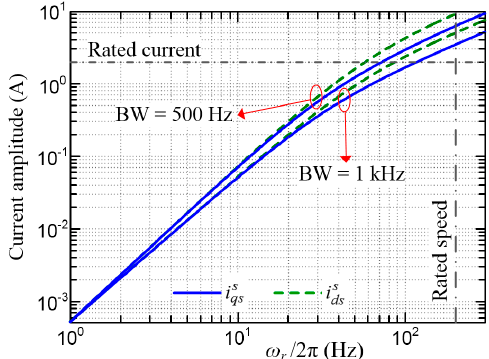
Figure 5. Frequency response of the induced current.